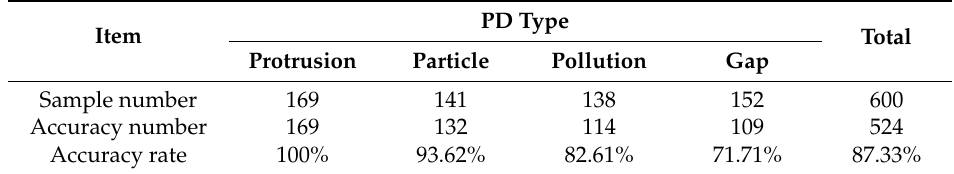
Table 6. Recognition result using the concentration ratios of SF 6 decomposed components as the input